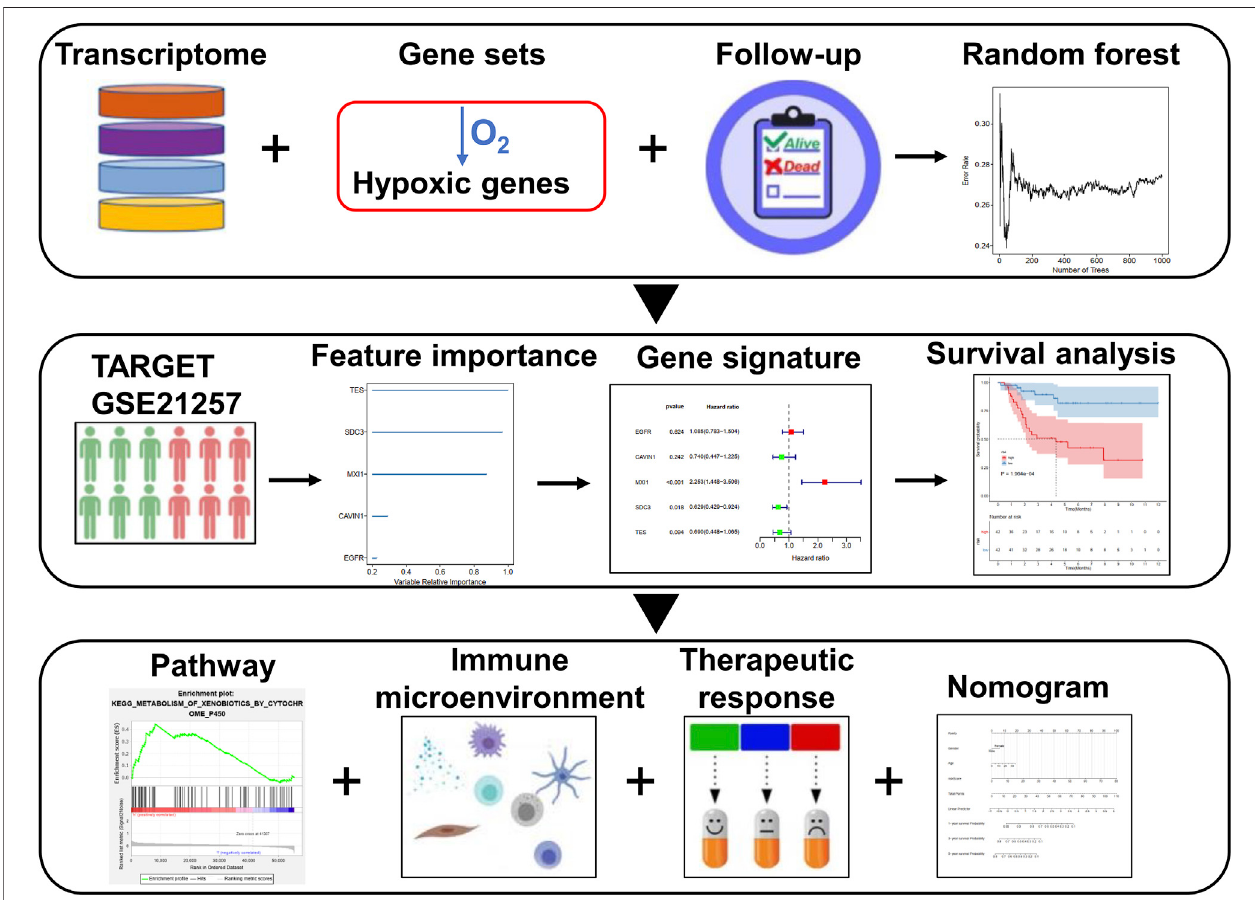
FIGURE 1 | Schematic diagram of the work fl ow of this